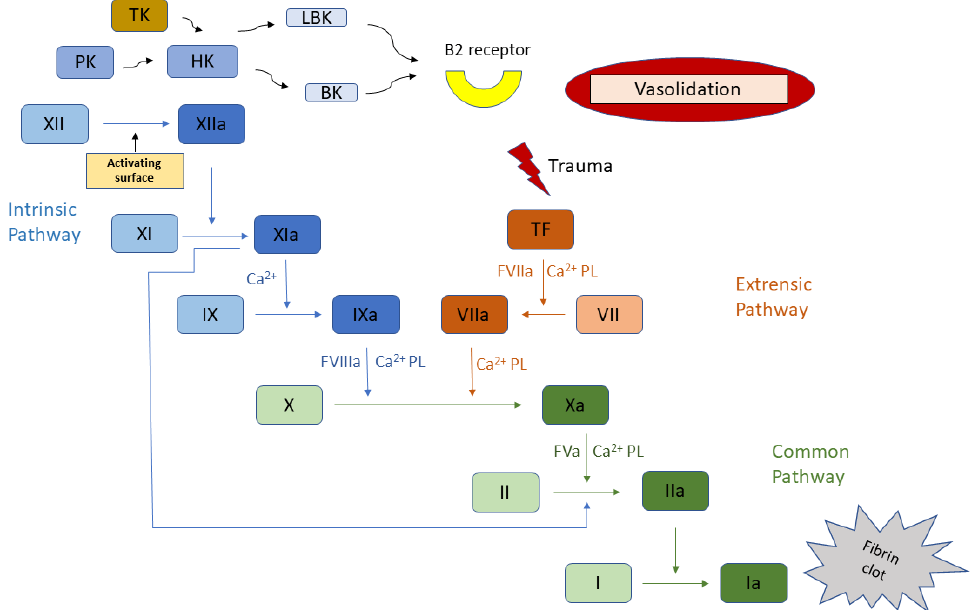
Figure 1. Blood coagulation cascade. Roman numerals denote individual coagulation factors, the letter “a” stands for the active form, other abbreviations are as in the